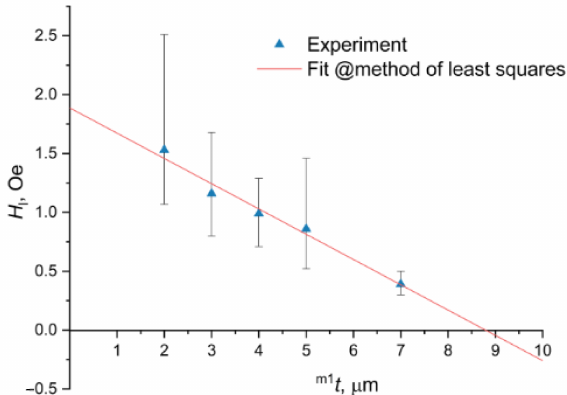
Figure 3. Photo of one of the investigated structures based on bidomain LN/Ni/Metglas.